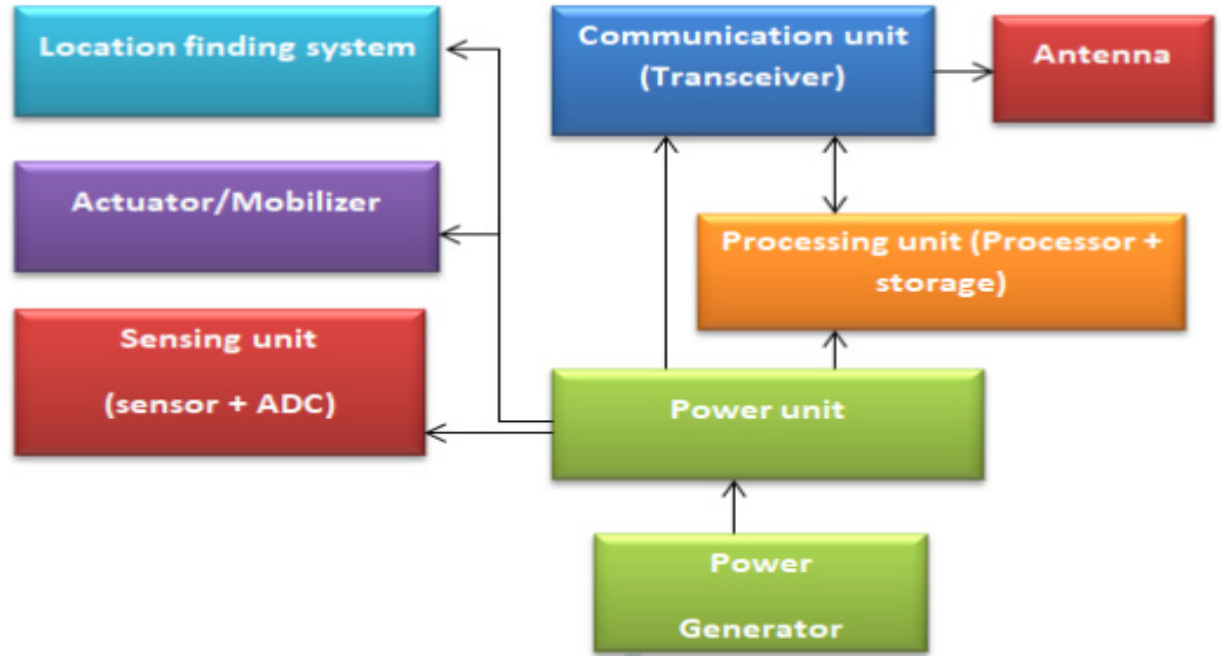
Figure 3. Sensor node